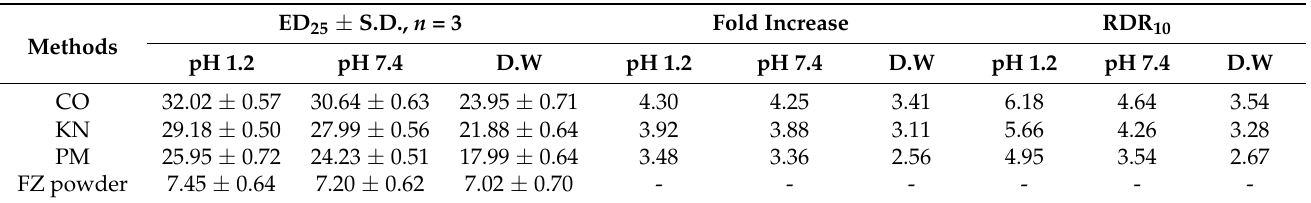
Table 2. The Dissolution Efficiency (ED 25 ) and Relative Dissolution rate (RDR 10 ) in different media for the co-evaporate (CO), kneaded (KN), physical mixture (PM), and fluconazole alone; ( n = 3, ±